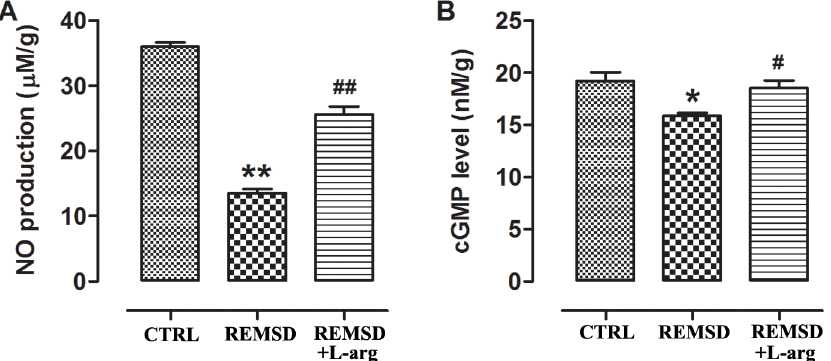
Fig 4. NO production and cGMP concentration in the aortas of middle-aged rats. (A)NO production.NO in the aorta was measuredusing the Greiss reagent. (B) cGMP concentration,cGMP in the aorta was measuredusing ELISA. Data were expressedas means ± SEM; n = 6. * P < 0.05and ** P < 0.01 vs . CTRL; # P < 0.05 and ## P < 0.01 vs . REMSD. CTRL, control rats without REM sleep deprivation; REMSD, REM sleep deprivation; L-arg, L-arginine.